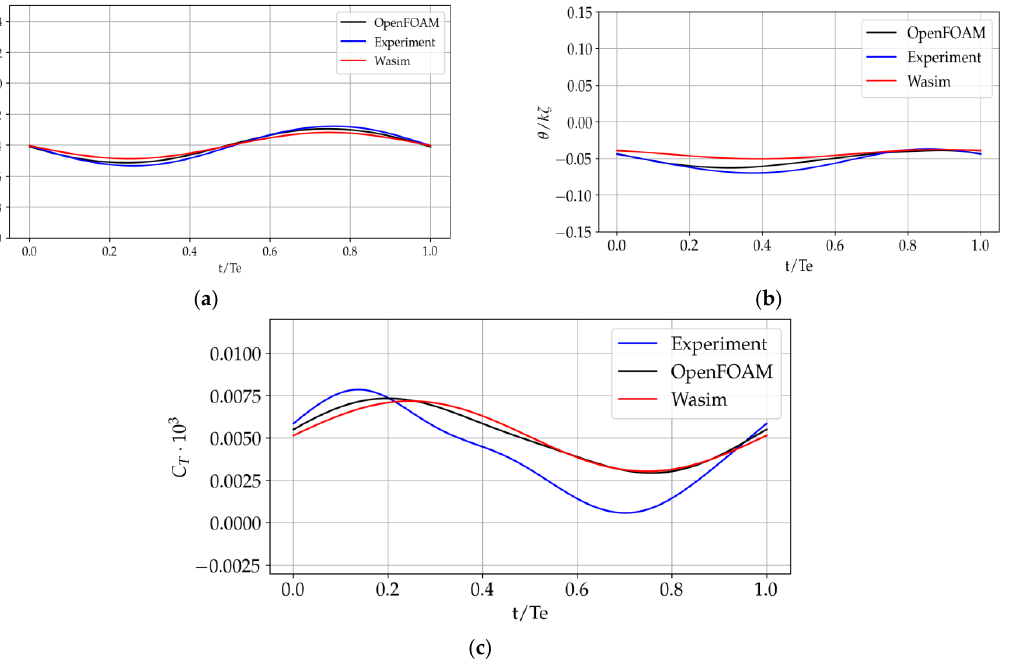
Figure 22. Time histories for case 1 of the KRISO containership: nondimensional ( a ) heave, ( b ) pitch, ( c ) total resistance.